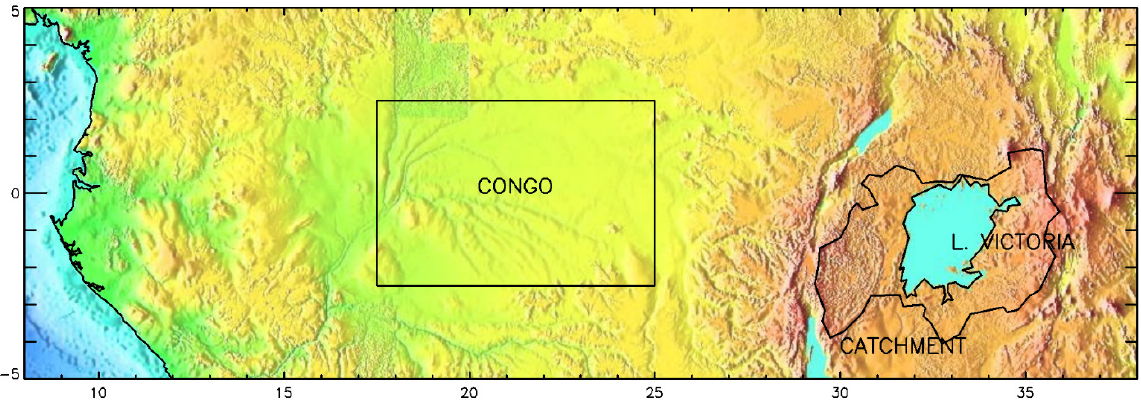
Figure 1. Map of locations: Congo Basin, Lake Victoria, and Lake Victoria catchment.